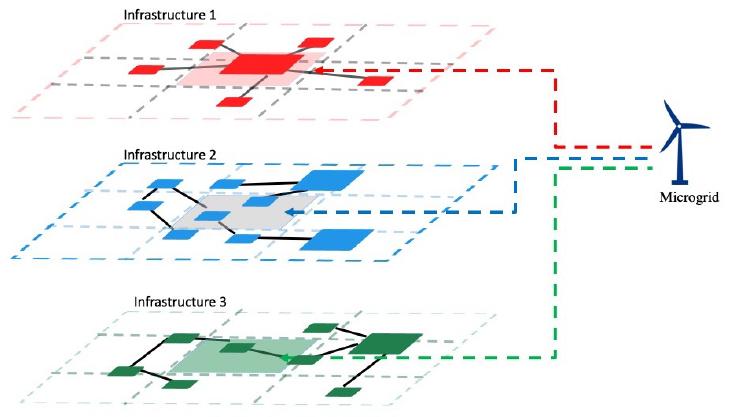
Figure 2. Geographic overlaid infrastructures connected to a